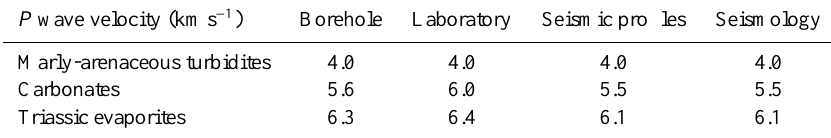
Table 1. Average P wave velocity for the lithologies encountered in the Mt. Civitello borehole.